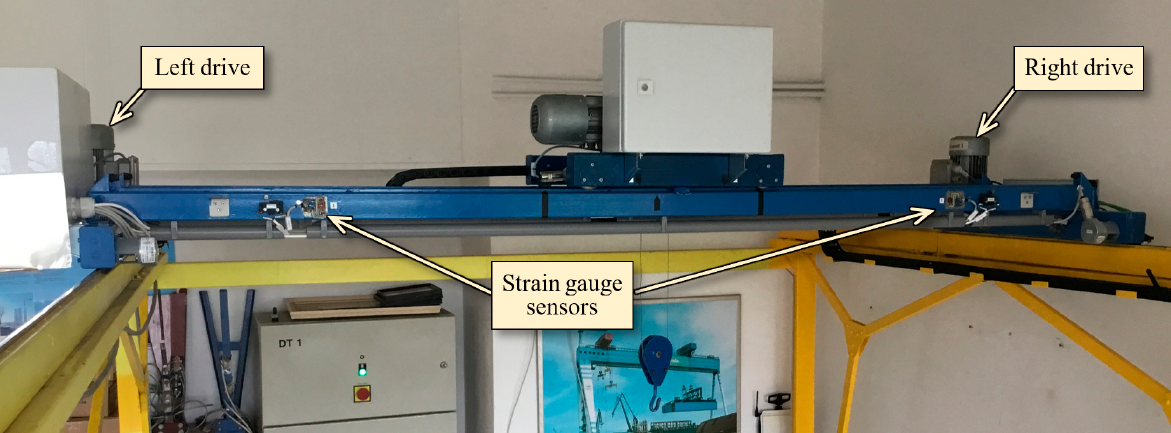
Figure 7. View of the bridge crane installed in the laboratory.